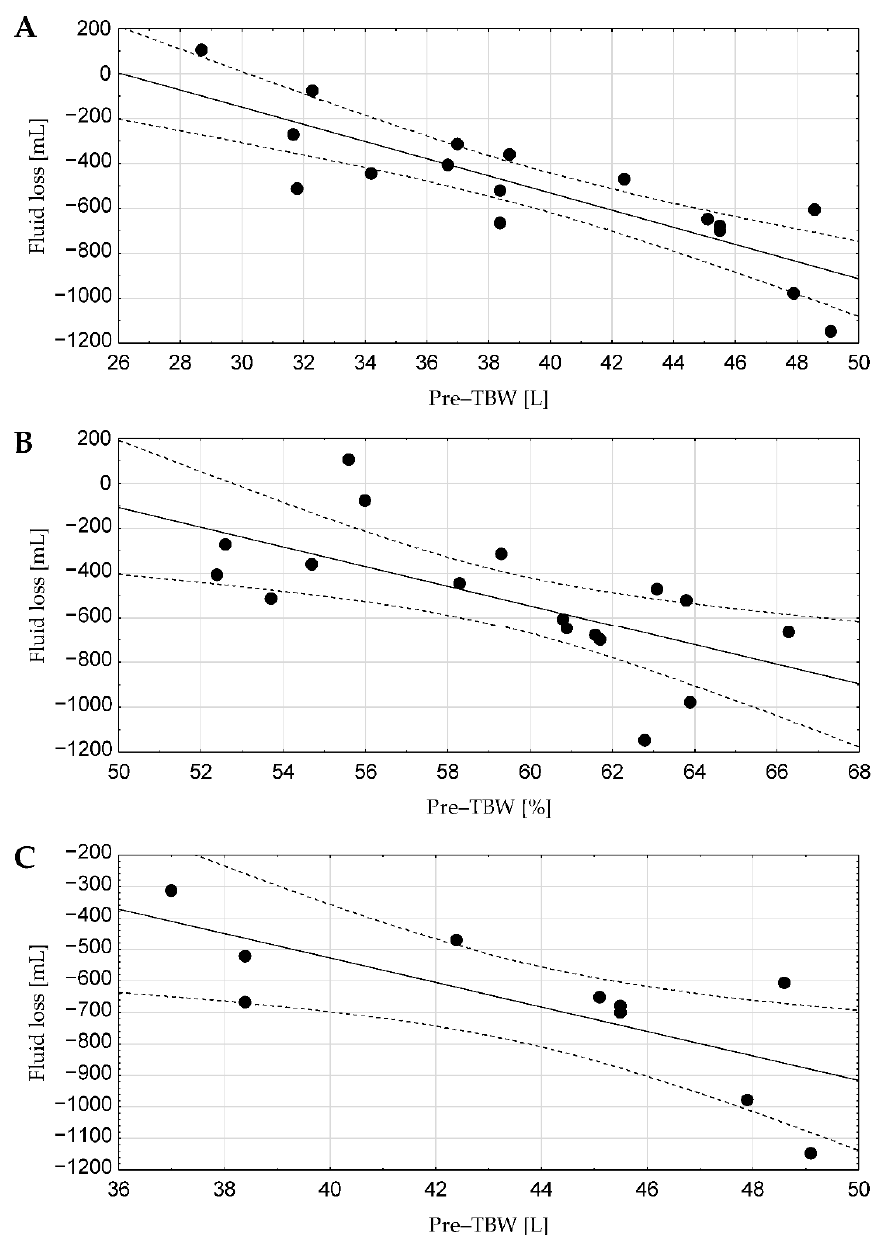
Figure 2. ( A – C ) present relationships between actual fluid loss and total body water content before training in the whole study group (mL vs. L ( A ) and mL vs. % ( B )), also in the group of males (mL vs. L ( C )). The black dots represent the values of the individual participants.